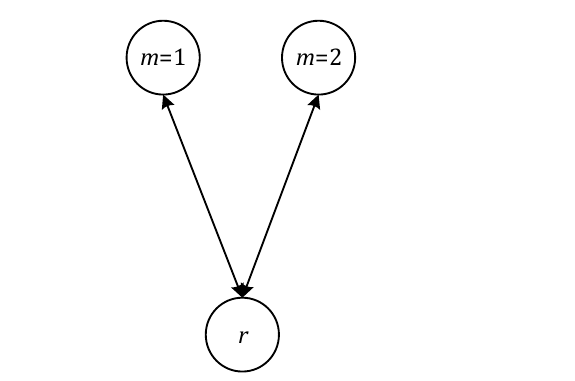
Fig. 2. Interaction between the wholesalers and retailer in the centralized